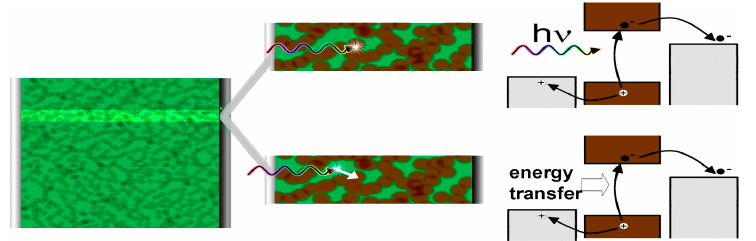
Figure 7. Schematic of a PSOTT/quantum dot blend “Schottky-diode” type junction. The hole-collecting electrode is denoted by a vertical light gray bar at left. The green is the PSOTT polymer and the brown circles are PbS quantum dots. The electron collecting LiF/Al contact is drawn as a darker grey vertical strip at right side. The highlighted horizontal strip shows two routes for generating photocurrent in the Schottky–diode device. In the upper image, a photon is absorbed by a quantum dot. In the bottom image, the photon is absorbed by the polymer and the energy of photon is then transferred to the quantum dot. The mechanisms drawn at the right simulates the dissociation of exciton by the mentioned mechanism. Reproduced from [34] with permission of the Royal Society of Chemistry.